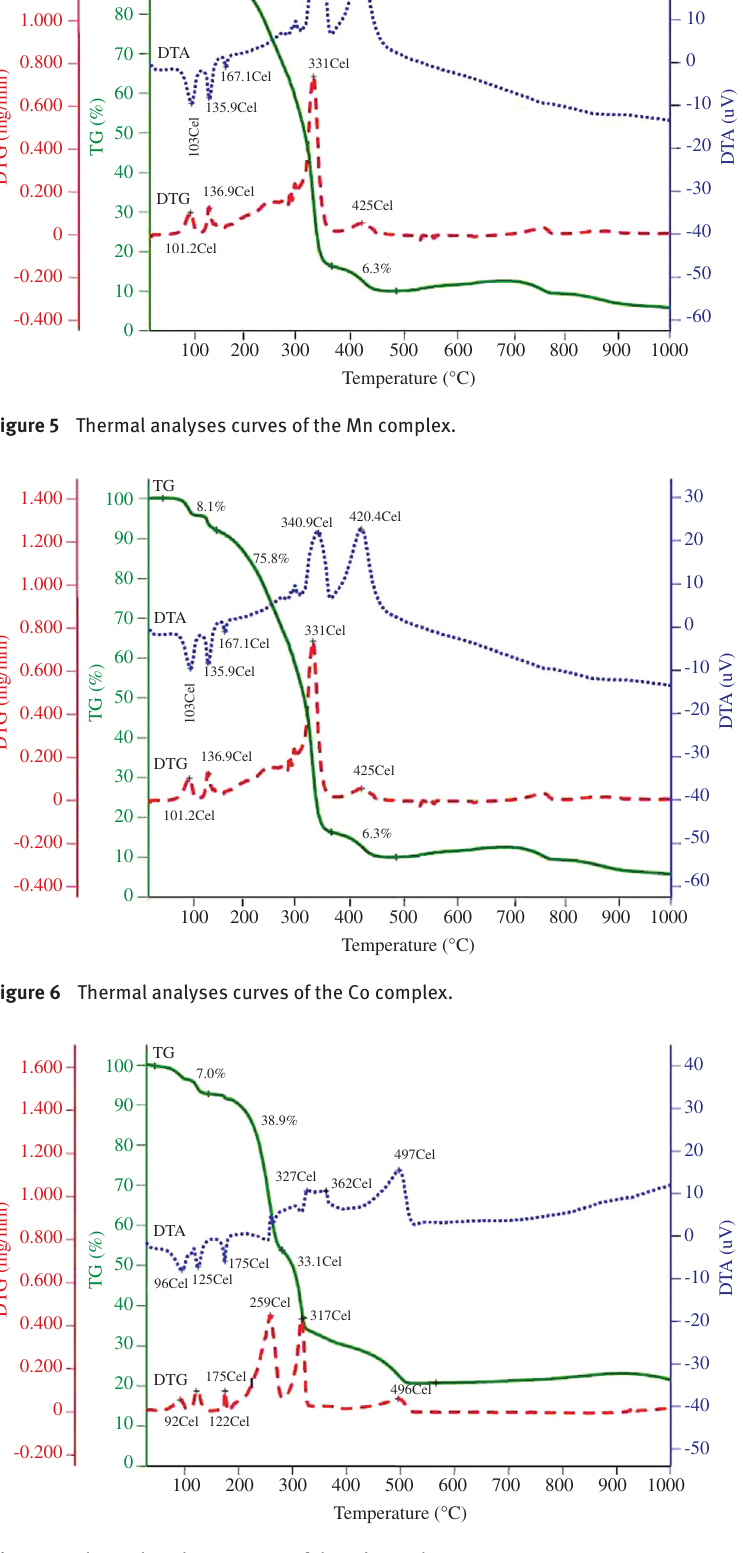
Figure 7 Thermal analyses curves of the Cd complex.